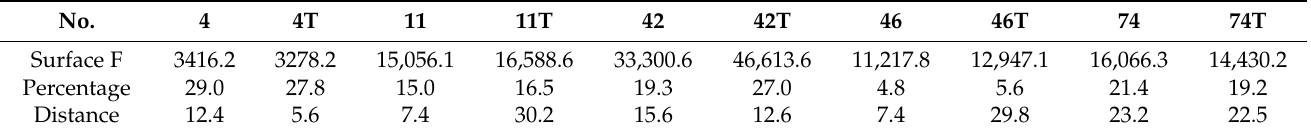
Table 8. Location data being validated and location data they are compared with.